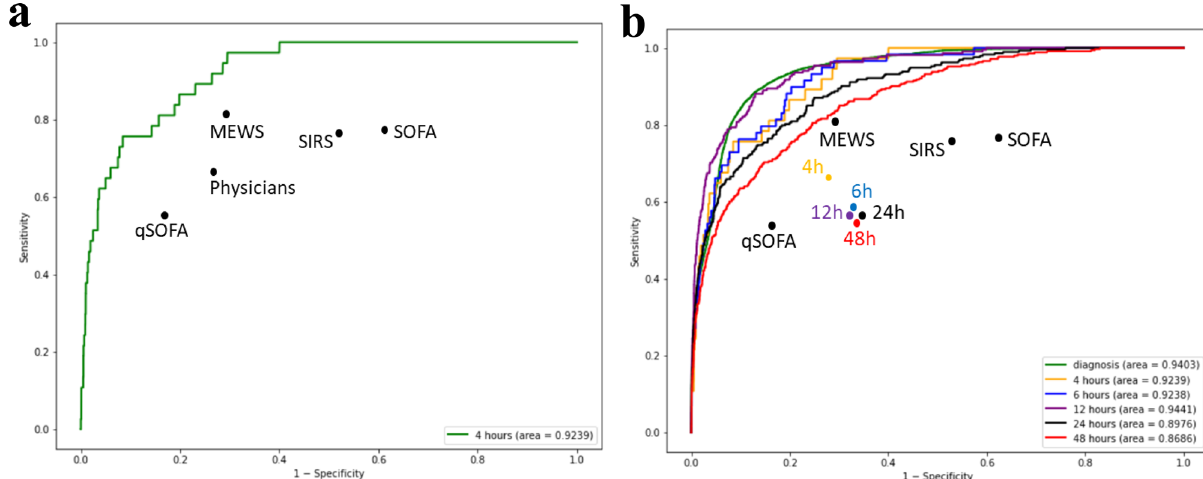
Fig. 2 ROC curves for 48, 24, 12, 6, and 4-h early prediction. a , b The ROCs represent the performance of early prediction algorithm at 4, 6, 12, 24, and 48 h prior to the onset of sepsis using the independent, test sample. “ qSOFA ” , “ MEWS ” , “ SIRS ” , and “ SOFA ” represent the TPR and FPR from these methods employed by physicians in prior studies at 0 – 4 h prior to the onset of sepsis. “ Physicians ” represent TPR and FPR of patients in the independent, test sample set that were suspected by hospital ’ s physicians to have sepsis at 4 h prior to the onset of sepsis. b “ 4 h ” , “ 6 h ” , “ 12 h ” , “ 24 h ” , and “ 48 h ” represent TPR and FPR of patients in the independent, test sample set that were suspected by hospital ’ s physicians to have sepsis at the respective time prior to the onset of